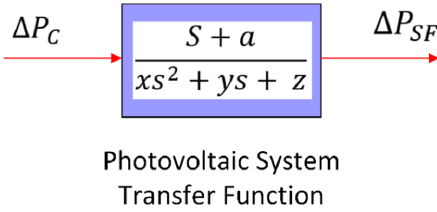
Figure 6. Model of photovoltaic panel transfer function.